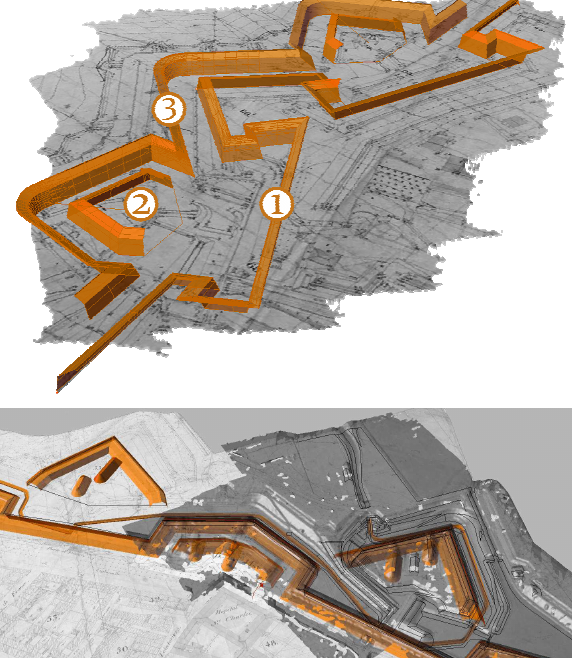
Figure 8. 3D parametric model of some fortification works placed on digitised maps and plans-reliefs: a bastioned front (1), a demi-lune (2) and a couterscarp